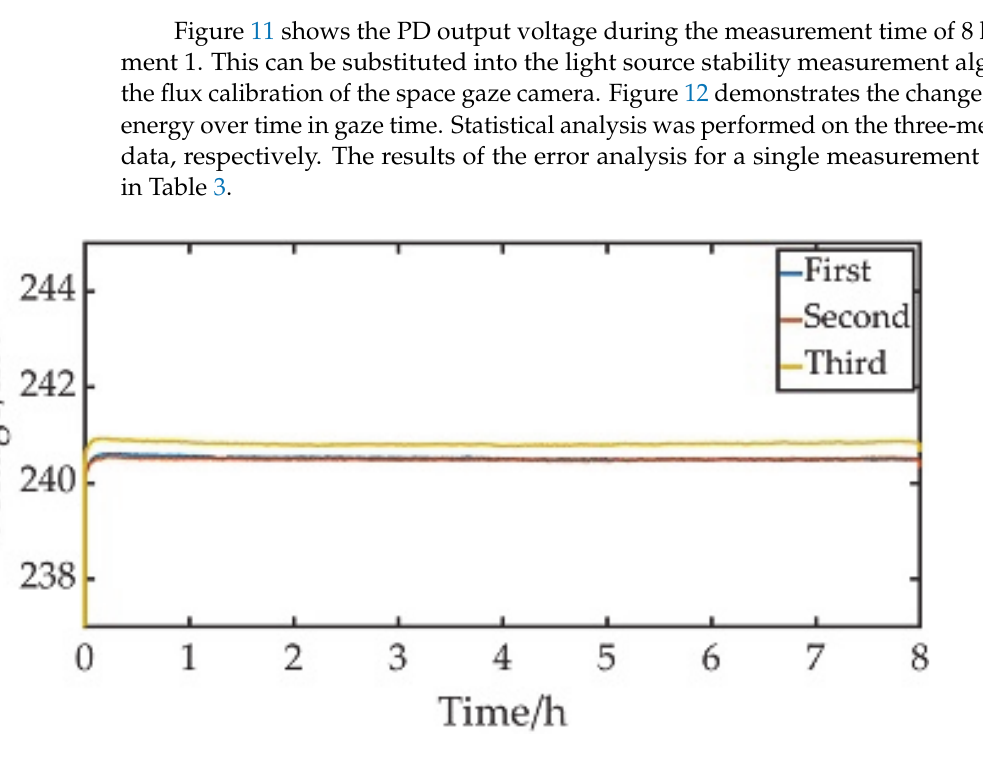
Figure 12. Variation in the total energy received with time during the PD gaze time in Experiment 1. Table 3. The relative uncertainty of PD stability in Experiment 1. Number Estimated Value (mW)